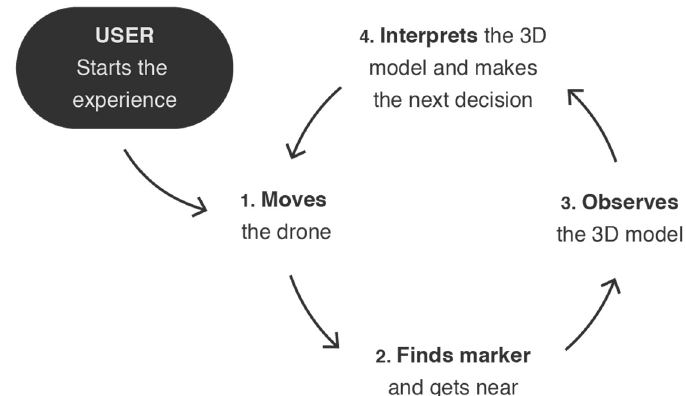
Figure 5. Feedback loop of the application representing the actions of the user.